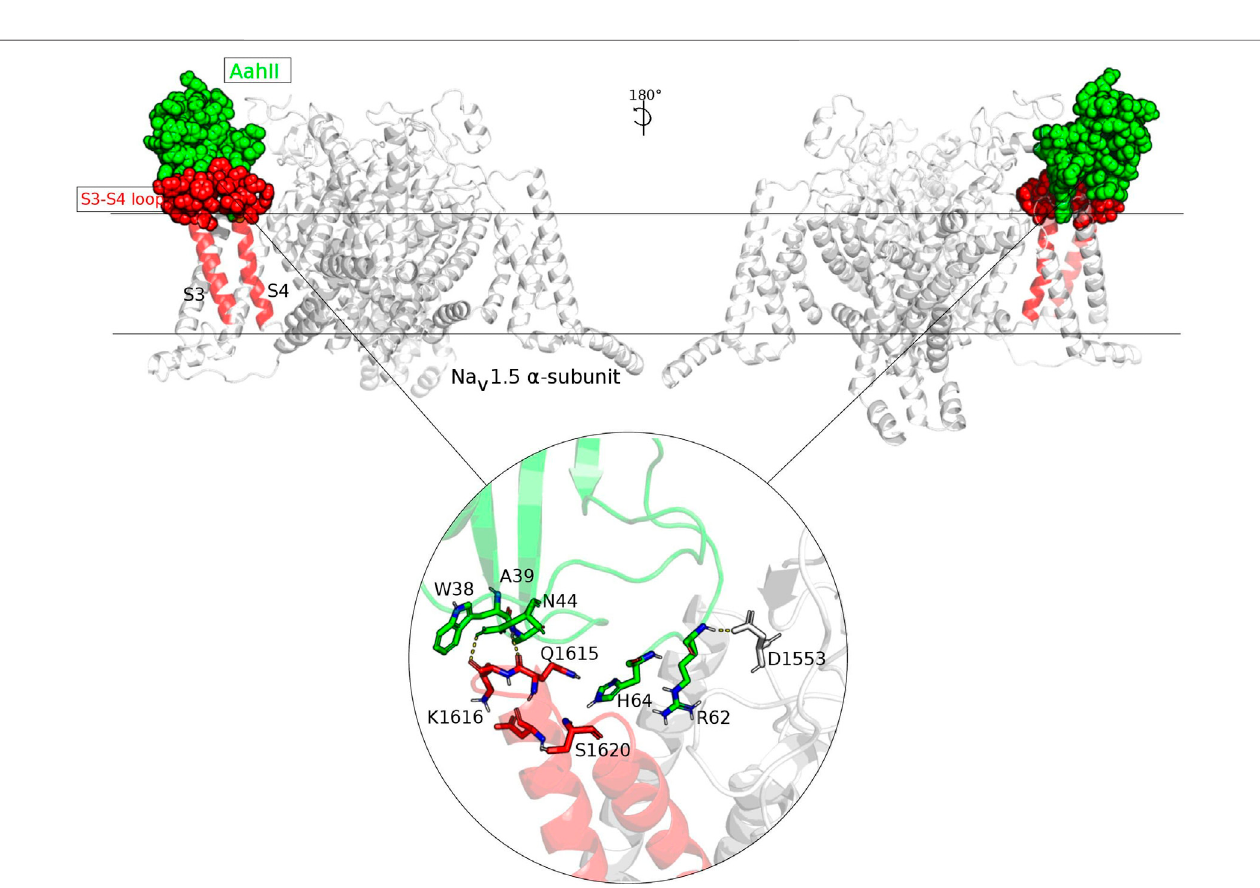
FIGURE 4 | Two faces of the Na V 1.5 – AahII molecular interaction presentation. The two faces of the Na V 1.5 – AahII molecular interaction are presented with an orientationof180 ° .ThesubunitinvolvedintheinteractionwascoloredinredandAahIIscorpiontoxiningreen.TheextracellularS3 – S4looppartofthesubunitinteracting with AahII is presented in spheres. This molecular orientation is selected among hundreds of poses according to a very accurate molecular docking approach. The zoomedpartillustratedinacircleshowsthemostcrucialresiduesinvolvedinthecomplexinteractionandmaintainingastablemolecularorientation.Theseresidues make H-bounds, as well as hydrophobic and hydrophilic